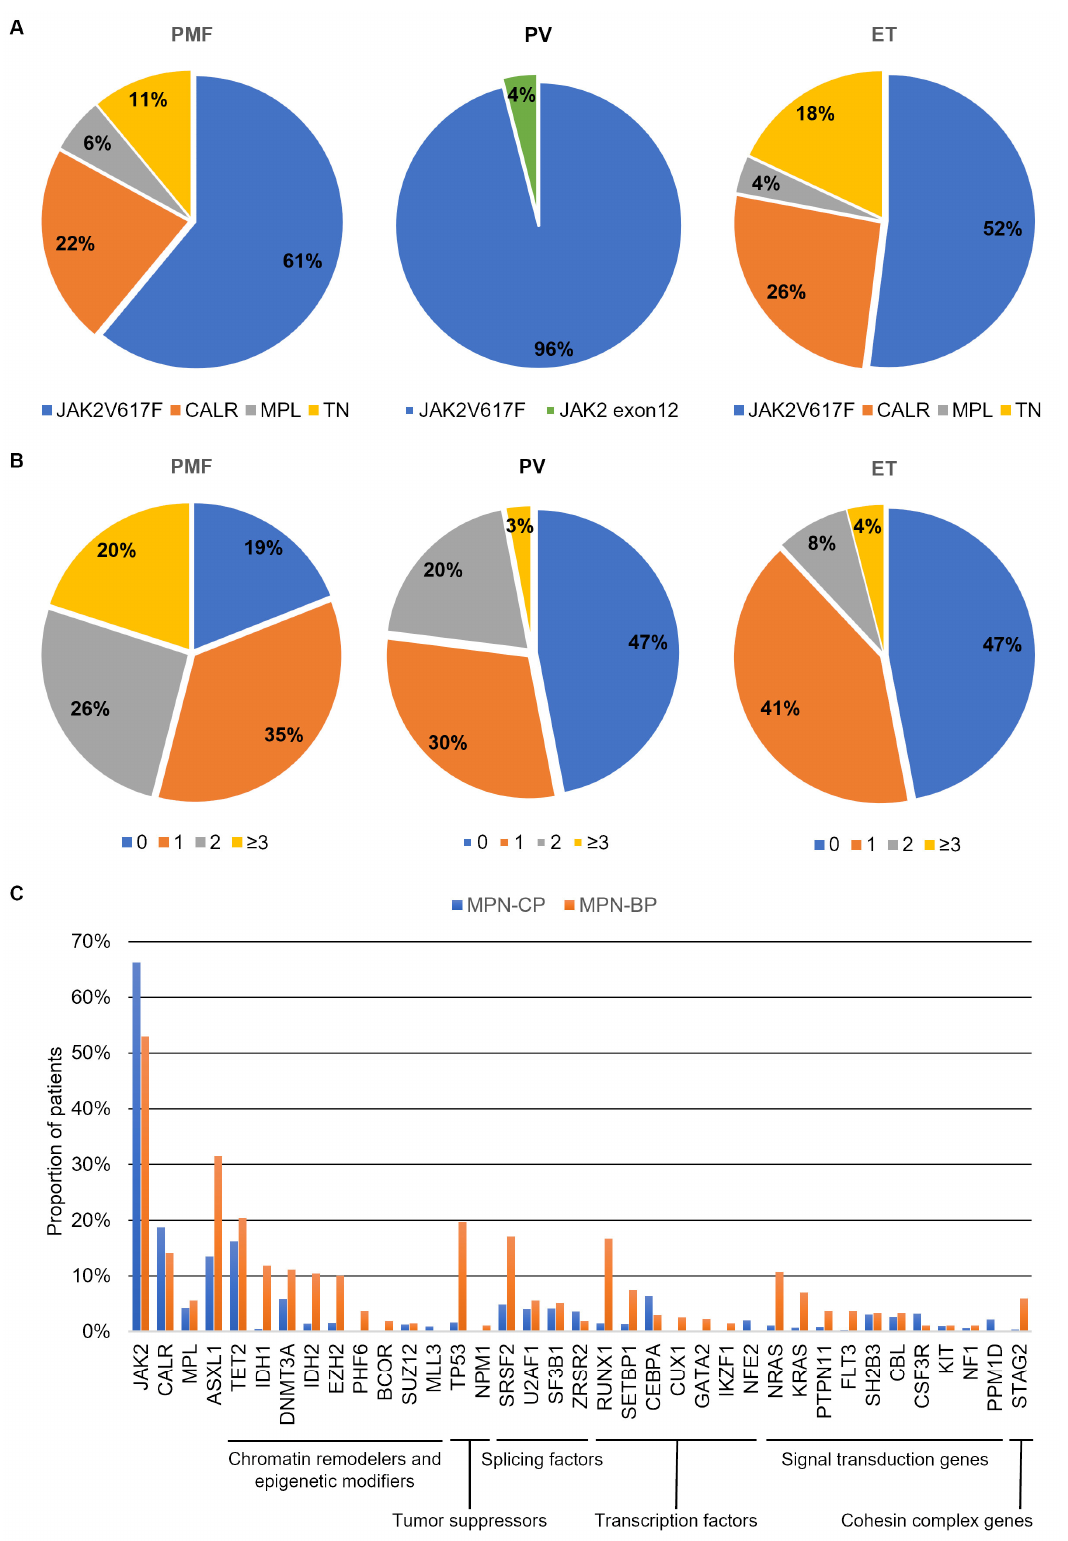
Figure 2. Molecular landscape in MPN-CP and MPN-BP. Panel ( A ) reports the frequency of patients harboring one of the three driver mutations considering PMF, PV and ET separately. In Panel ( B ) the proportion of patients harboring 0, 1, 2 or more than or equal to 3 variants other than the driver mutations is represented. Histogram in Panel ( C ) compares the frequency of patients harboring each mutation in MPN-CP and MPN-BP. Data adapted from: Tefferi et al., 2016 [21], Tefferi et al., 2016 [22], Grinfeld et al., 2018 [24], Venton et al., 2018 [25], Lasho et al., 2018 [26] and McNamara et al., 2018 [27].